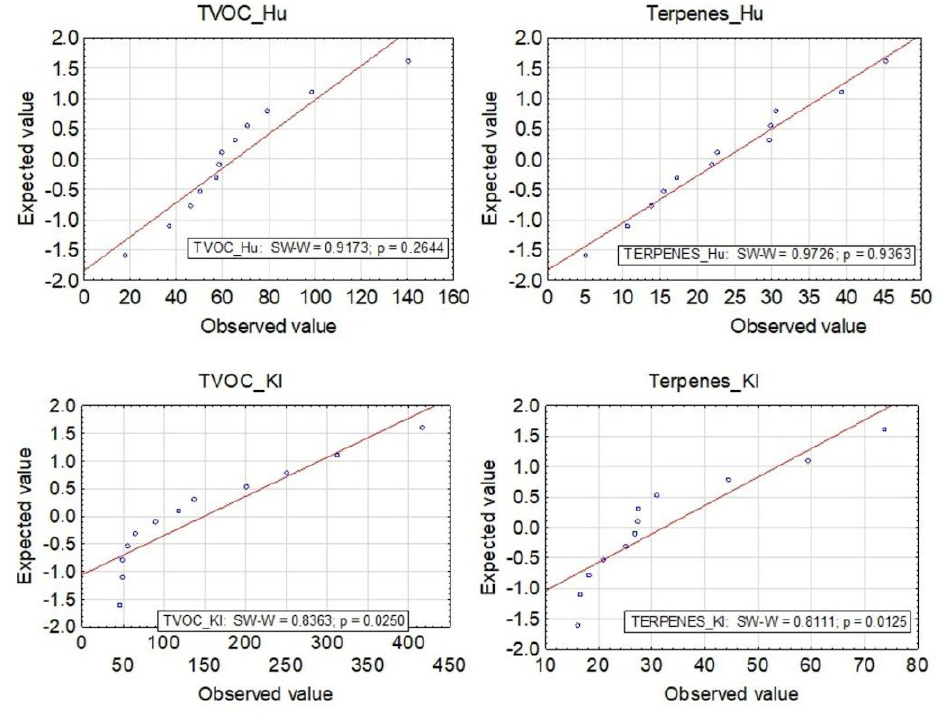
Figure 5. TVOC and terpene distribution investigated by Shapiro–Wilk